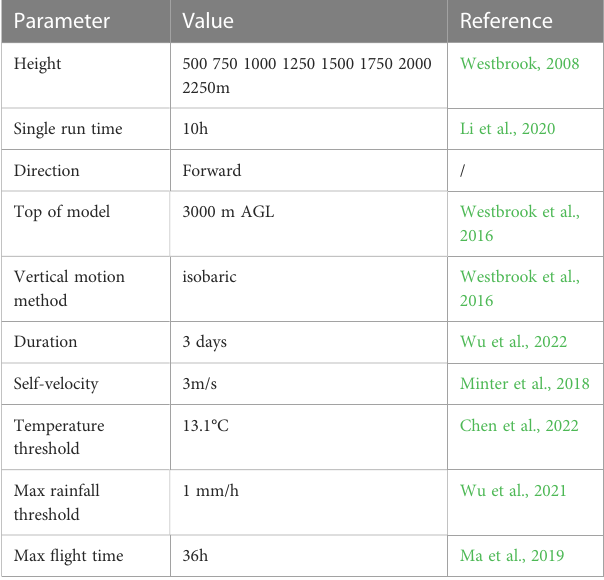
algorithm in ArcGIS 10.6 for the effective trajectories landing points. The ellipse was based on 95% of the effective landing points, and its center, the length of the long and short axes, and the angle of rotation relative to due north could indicate the location, range, and directional distribution of the potentially affected area. Speci fi cally, the elliptical axis indicates the range of the affected distribution, and the ratio of the long axis to the short axis can indicate the dispersal direction and trend of FAW, the larger the ratio, the more obvious the trend of the landing points distribution, if the short axis and the long axis are equal, the landing points distribution is directionless. We used paired t-test to compare whether long and short axes of the standard deviation ellipse are signi fi cantly different by month and year respectively, to determine whether the distributions are signi fi cantly directional.